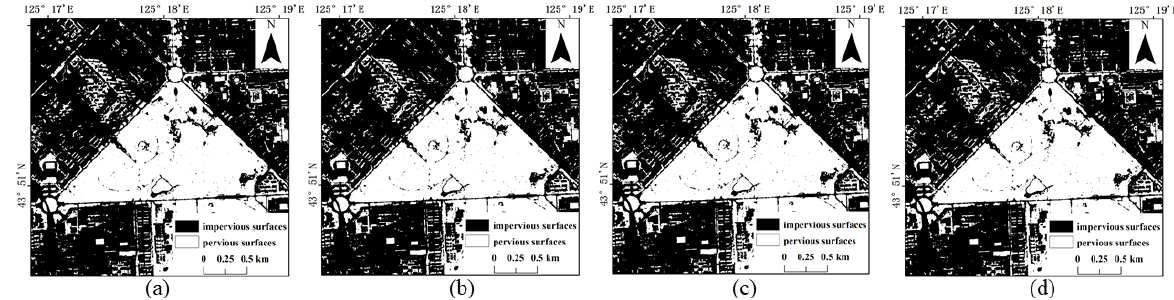
Figure 6. Results of impervious surface extraction with RF: ( a ) 40,000 samples; ( b ) 60,000 samples; ( c ) 80,000 samples; ( d ) 100,000 samples.